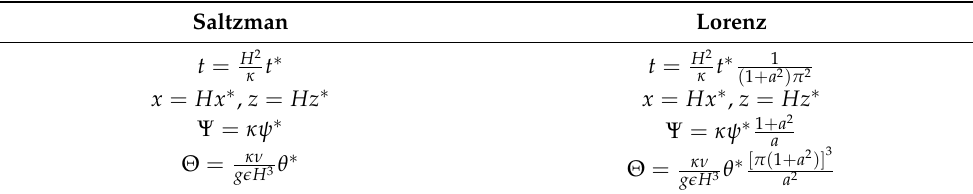
Table 1. Nondimensional forms of Saltzman and Lorenz variables. The superscript asterisk (*) denotes the nondimensional variables where physical parameters for the model follow: g , H , κ , ν , (cid:101) : acceleration of gravity, depth of the fluid, coefficient of thermal diffusivity, kinematic viscosity, and coefficient of volume expansion,